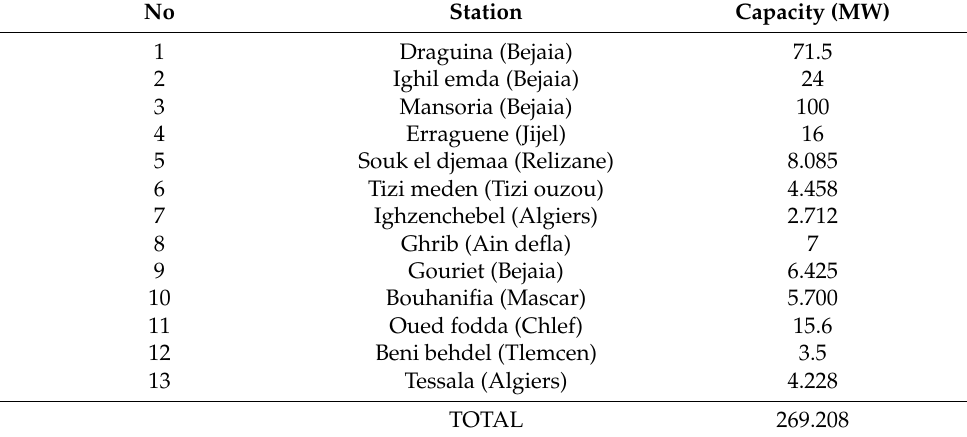
Table 9. Hydropower plants in